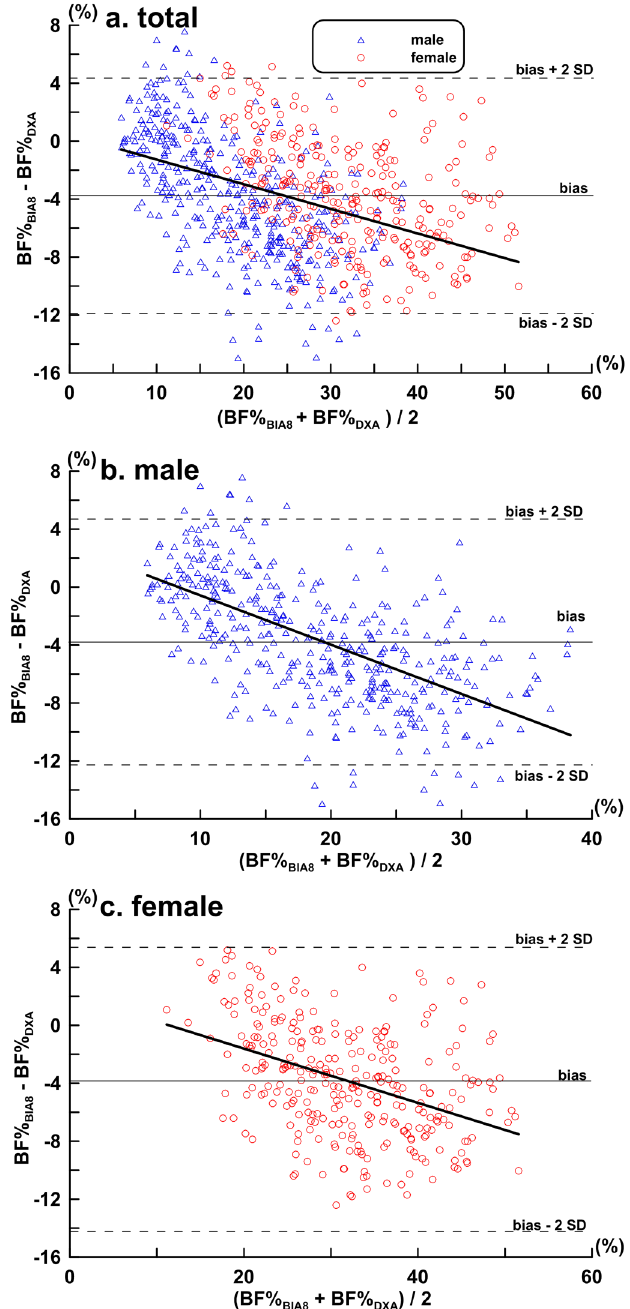
Fig 2. Bland-Altman plot of the difference between BF% BIA8 and BF% DXA in mean difference expressed as bias, 95% confidence interval expressed as bias ± 2 SD. (a) Total subjects ( n = 711); bias ± SD: -3.72 ± 4.09%, bias – 2SD: -11.90%, bias + 2 SD: 4.46%, regression equation y = - 0.170 x + 0.430 ( r = 0.42, P < 0.01); (b) Male ( n = 412); bias ± SD: -3.66 ± 4.24%, bias – 2SD: -12.14%, bias + 2 SD: 4.83%, regression equation y = - 0.340 x + 2.830( r = 0.61, P < 0.01); (c) Female ( n = 299); bias ± SD: -3.81 ± 3.87%, bias – 2SD: -11.56%, bias + 2 SD: 3.94%, regression equation y = - 0.187 x +2.134 ( r = 0.41, P <